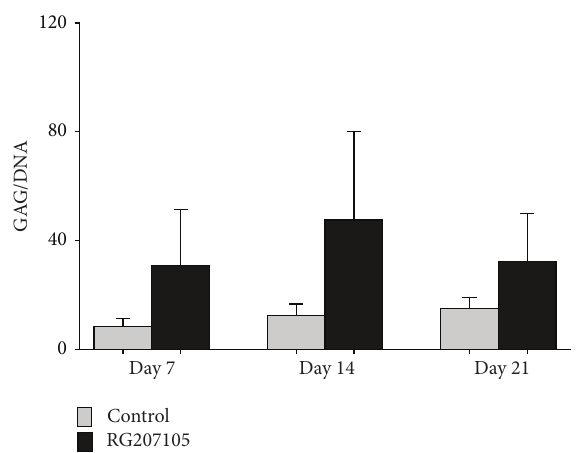
Figure 4: Glycosaminoglycan (GAG)/DNA ratio of alginate bead culture comparing transfected and untransfected cells over time.